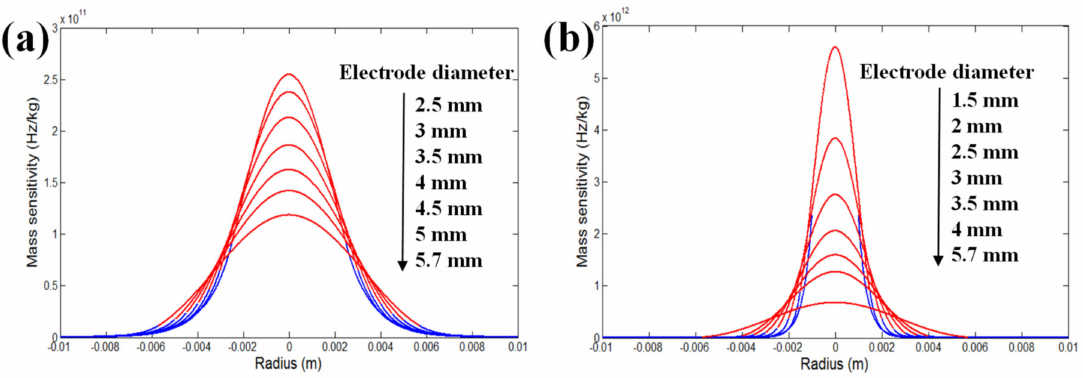
Figure 7. Mass sensitivity distribution profiles for AT-cut ( a ) 5 MHz and ( b ) 10 MHz QCMs with different electrode diameters [31].